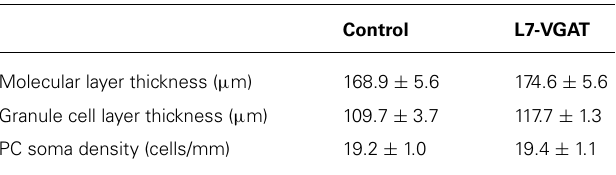
Table 2 |Anatomical comparison between control and L7-VGAT cerebella at postnatal 40